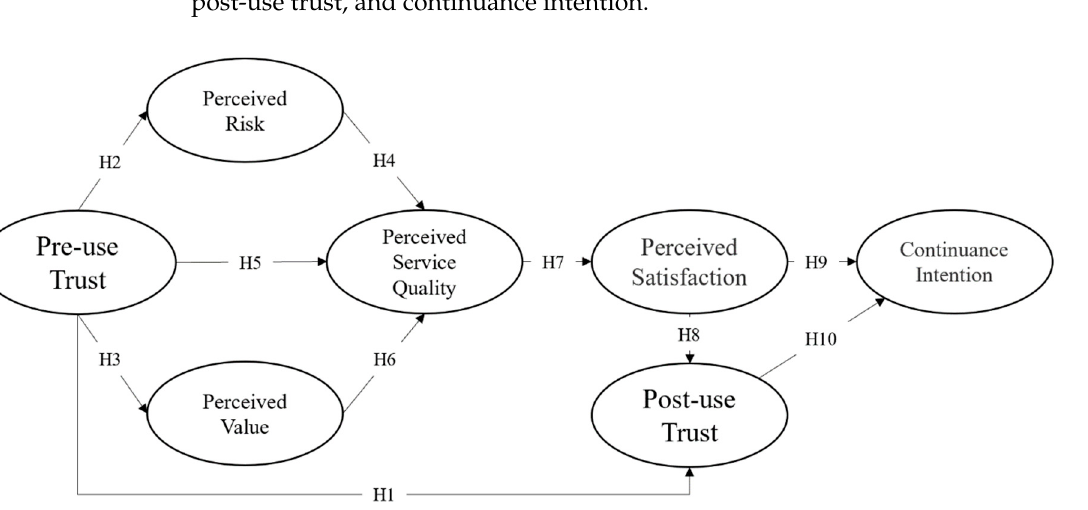
Table 1. Definition of variable operability and reference scales.